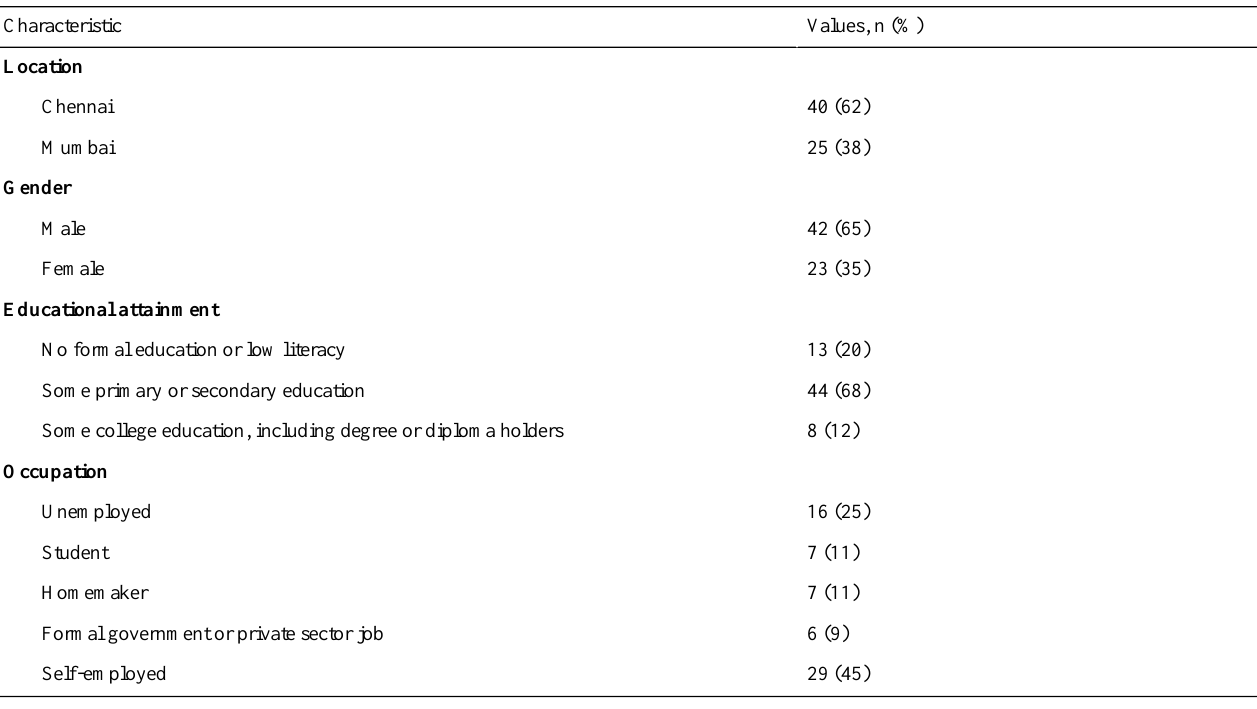
Table 1. Descriptive statistics for patients with multidrug-resistant tuberculosis being monitored with the Medication Event Reminder Monitor.